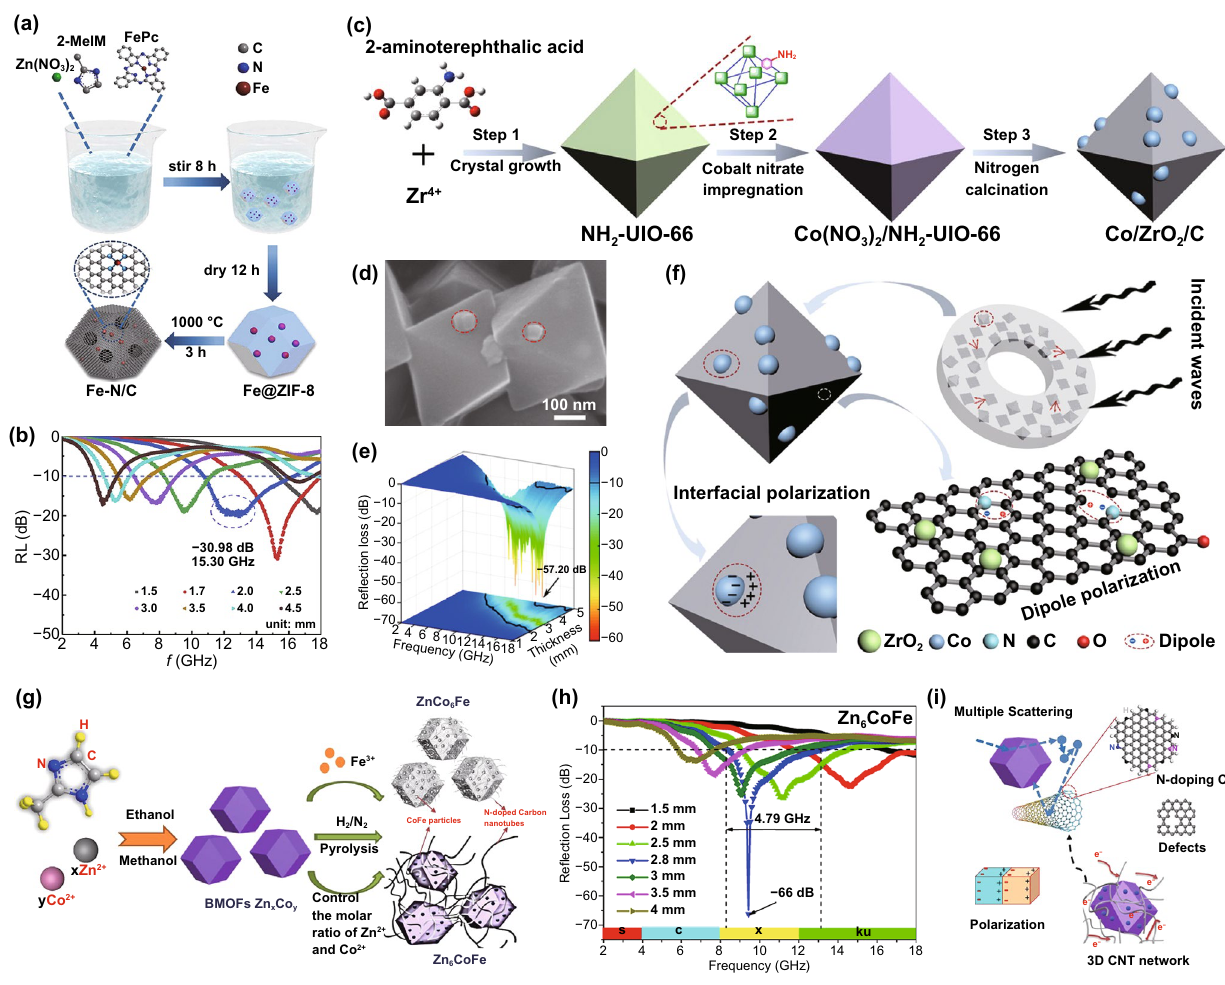
Fig. 13 a Diagrammatic sketch of the synthesis and b RL-f curves of Fe–N/C. Reprinted with permission from Ref. [129]. c Schematic illus- tration of the preparation, d SEM image, e 3D RL-f curves, f MA mechanism of Co/ZrO 2 /C octahedrons. Reprinted with permission from Ref. [127]. g Schematic diagram of synthesis, h RL-f curves and i schematic representation of MA mechanism of Zn x Co y Fe@C@CNTs. Reprinted with permission from Ref.